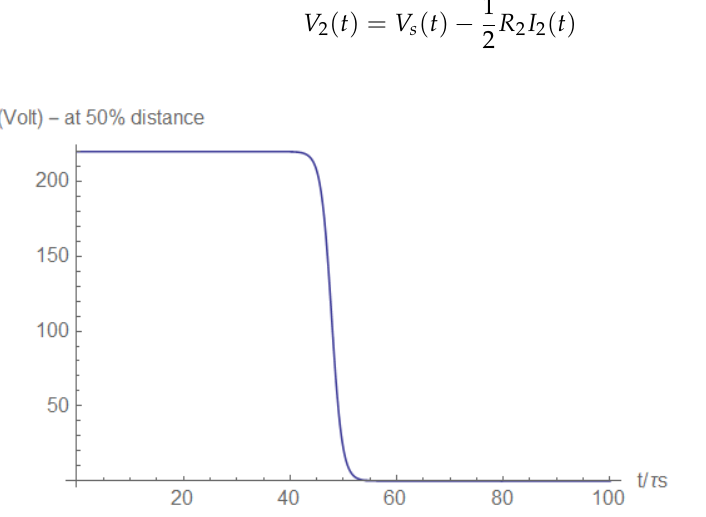
Figure A14. Voltage at half the distance between the short and the load.